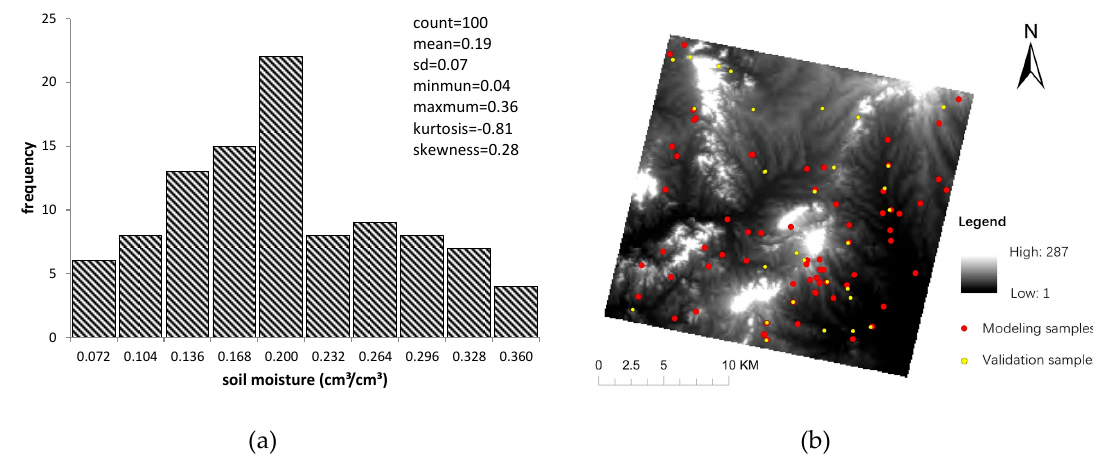
Figure 5. ( a ) Statistical description of the soil moisture sampling data. ( b ) Map of the location and elevation (m) of the modeling and validation samples.